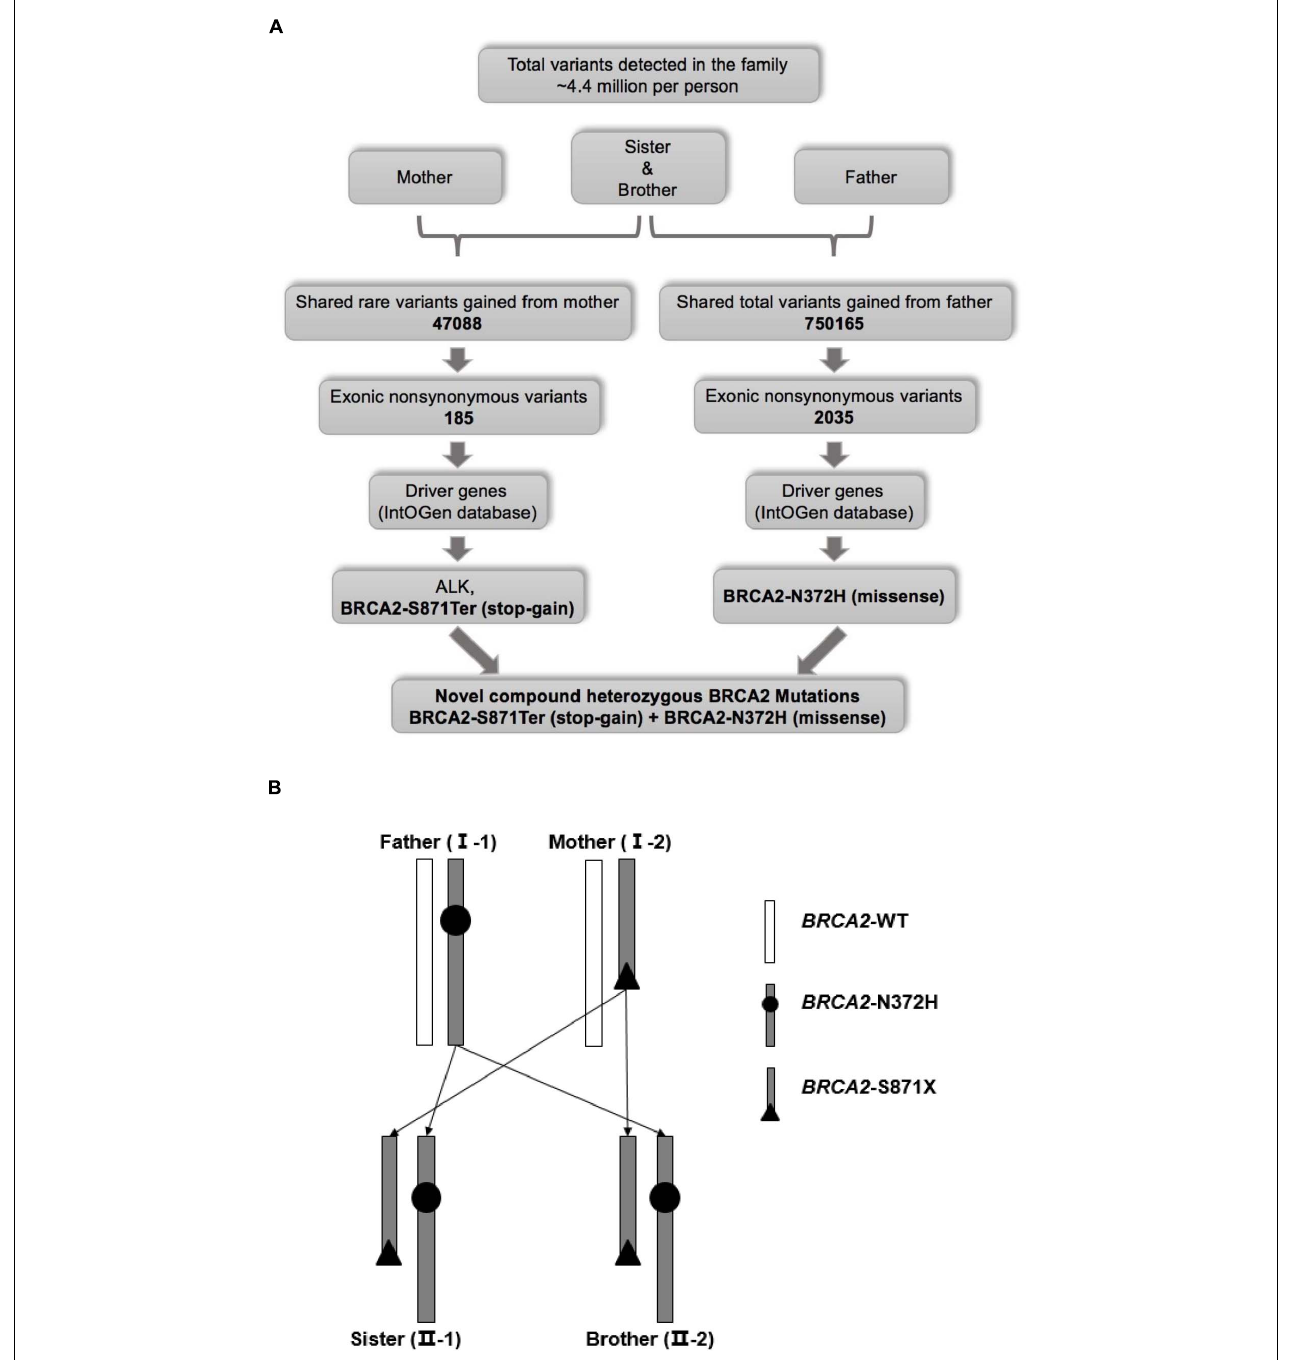
FIGURE 2 | (A) Workflow for the identification of pathogenic mutations. (B) Schematic diagram of genetic